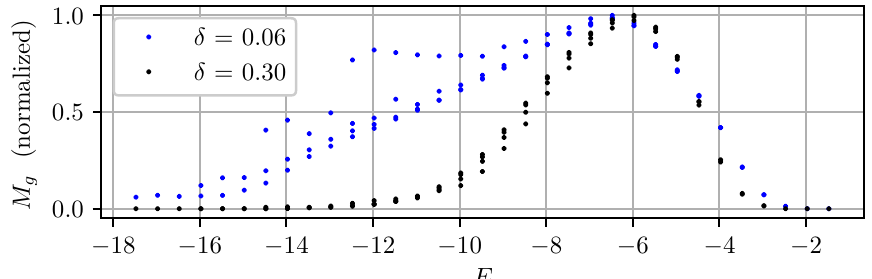
Figure 1. Comparison of the gradient information metric M g for different threshold values δ . Each dot represents the metric computed for an image of a static scene with a constant illuminance of about 50 lux captured with different gains and exposure